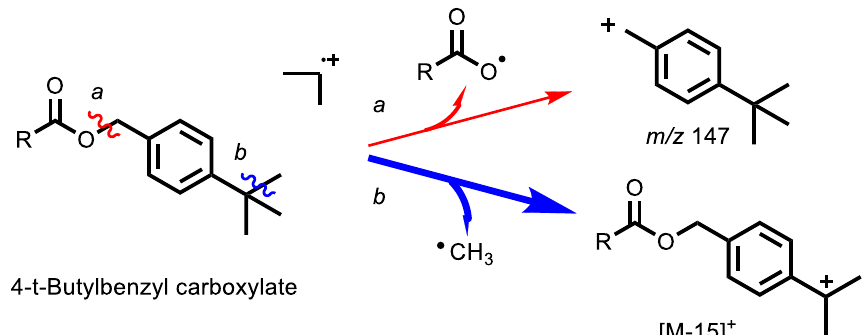
Fig. 1 The predicted frag- mentation of 4- t -butylbenzyl